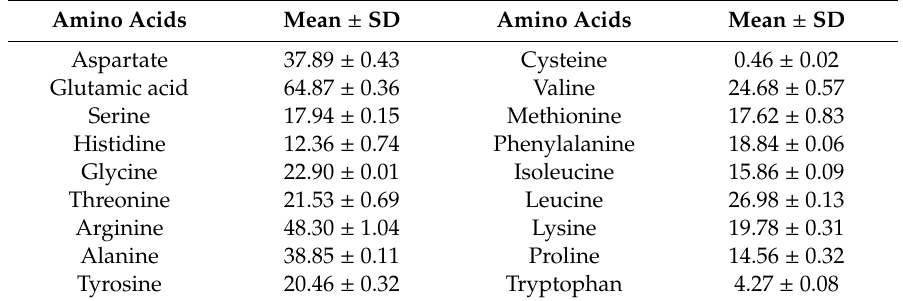
Table 6. Amino acid content of BSF biomass produced on VMD in mass rearing conditions (mg / g